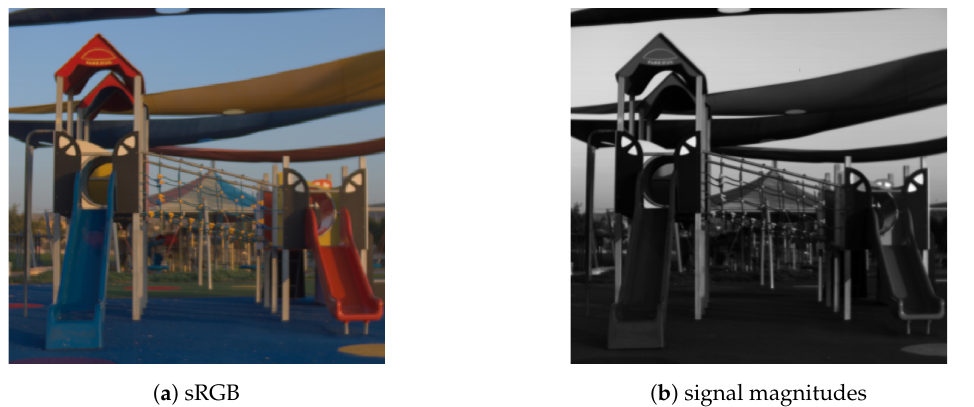
Figure 2. An exemplary image of the spectral dataset [11] once rendered in sRGB assuming CIE D50 lighting in the original scene ( a ) as well as the corresponding signal magnitudes per pixel ( b ).